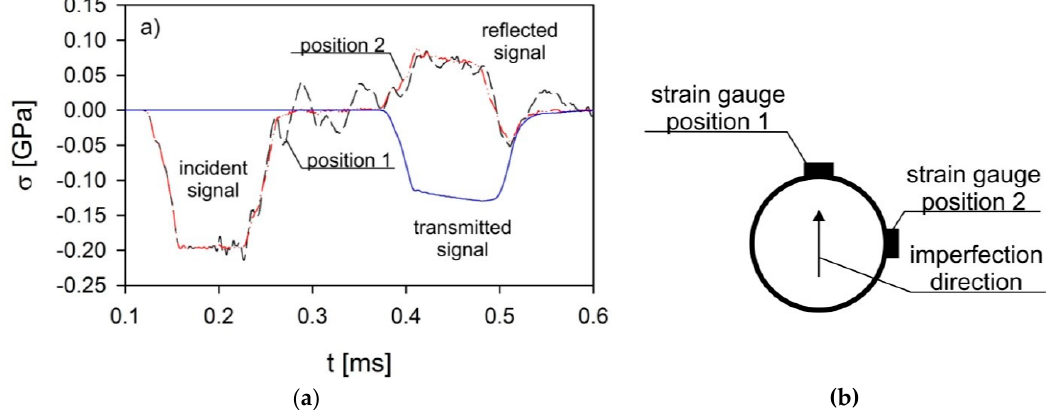
Figure 1. Disturbances of wave signals ( a ) depending on the relative position of the pulse shaper and the strain gauges ( b ) [14].